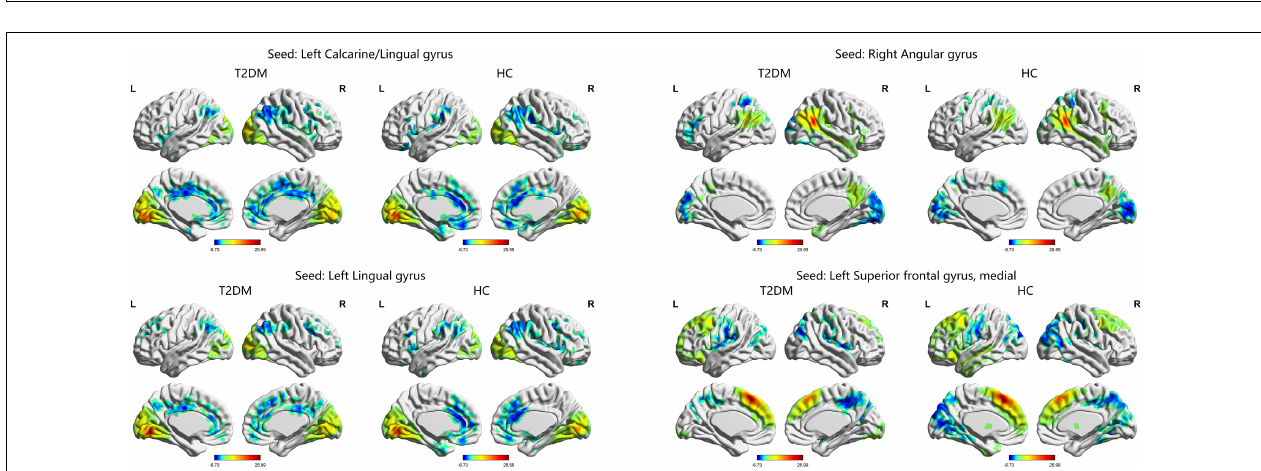
FIGURE 1 | The distribution of FCD in the T2DM group and HC group. Color scale denotes the t -value. L, left; R, right.